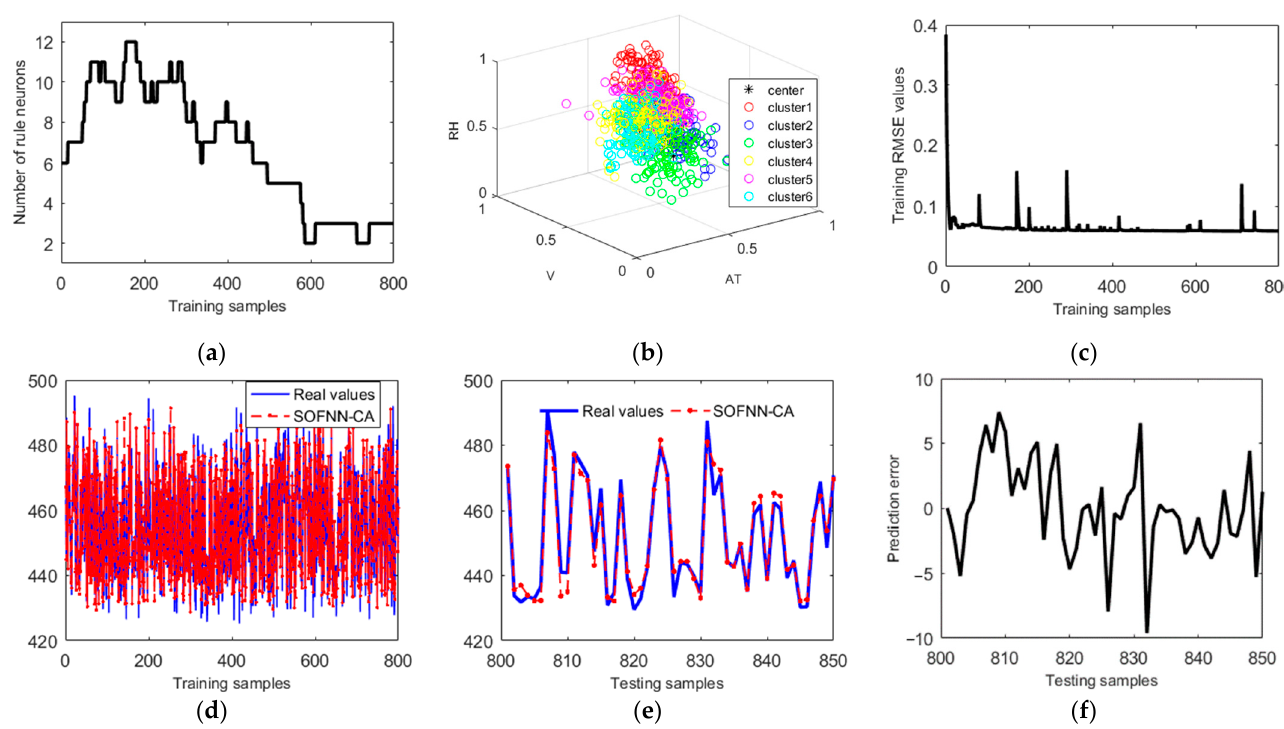
Figure 10. ( a ) Neuron change plot; ( b ) k-means clustering plot; ( c ) training RMSE plot; ( d ) training result plot; ( e ) test result plot; ( f ) test error plot.